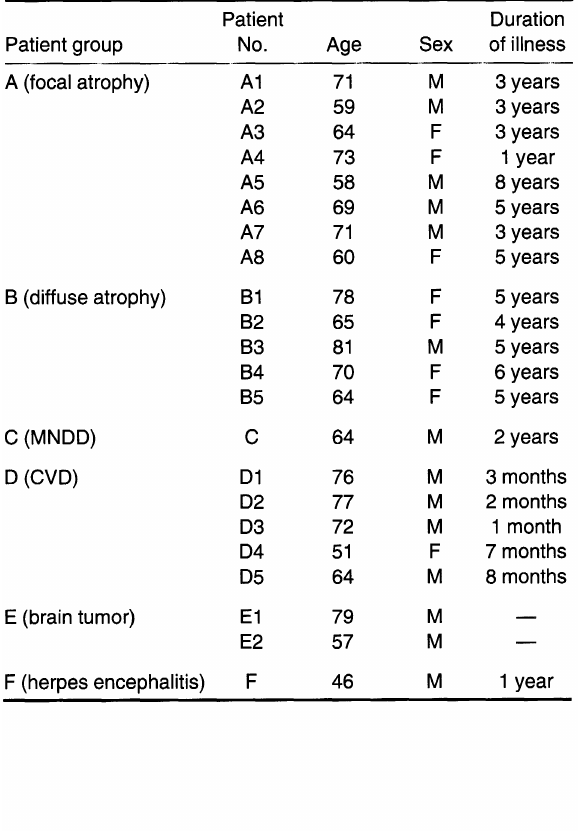
without understanding the meaning as a whole.